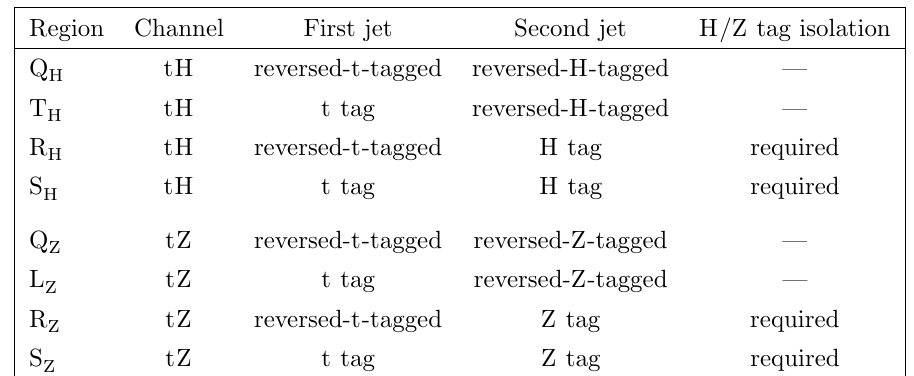
Table 3 . Overview of the criteria used to de(cid:12)ne the mutually exclusive Q L , R , and S regions. These are based on the particle tagging criteria for t, H, and Z jets and Z Z Z for the reversed-t-tagged, reversed-H-tagged, and reversed-Z-tagged jets using the two highest p AK8